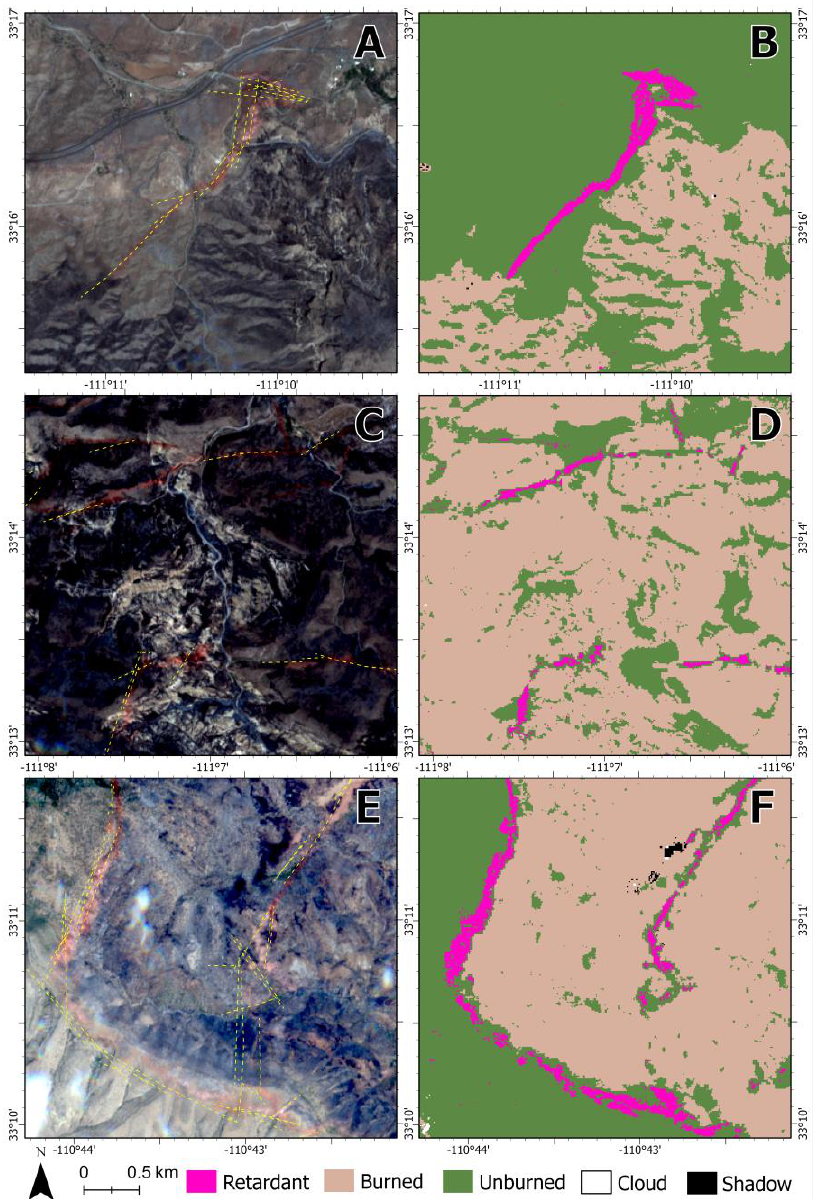
Figure 4. Gradient boosting model predictions on the held-out test dataset. Dashed lines show aerial GPS surveys (left panel images). ( A ) Telegraph, AZ post-application true-color imagery; ( B ) model prediction for ( A ); ( C ) Telegraph, AZ post-application true-color imagery; ( D ) model prediction for ( C ); ( E ) Mescal, AZ post-application true-color imagery; ( F ) model prediction for ( E ). Table 2. Model testing results with different data scenarios: binary, multiclass, post-application, and pre- and post-application difference images (* denotes the best model).